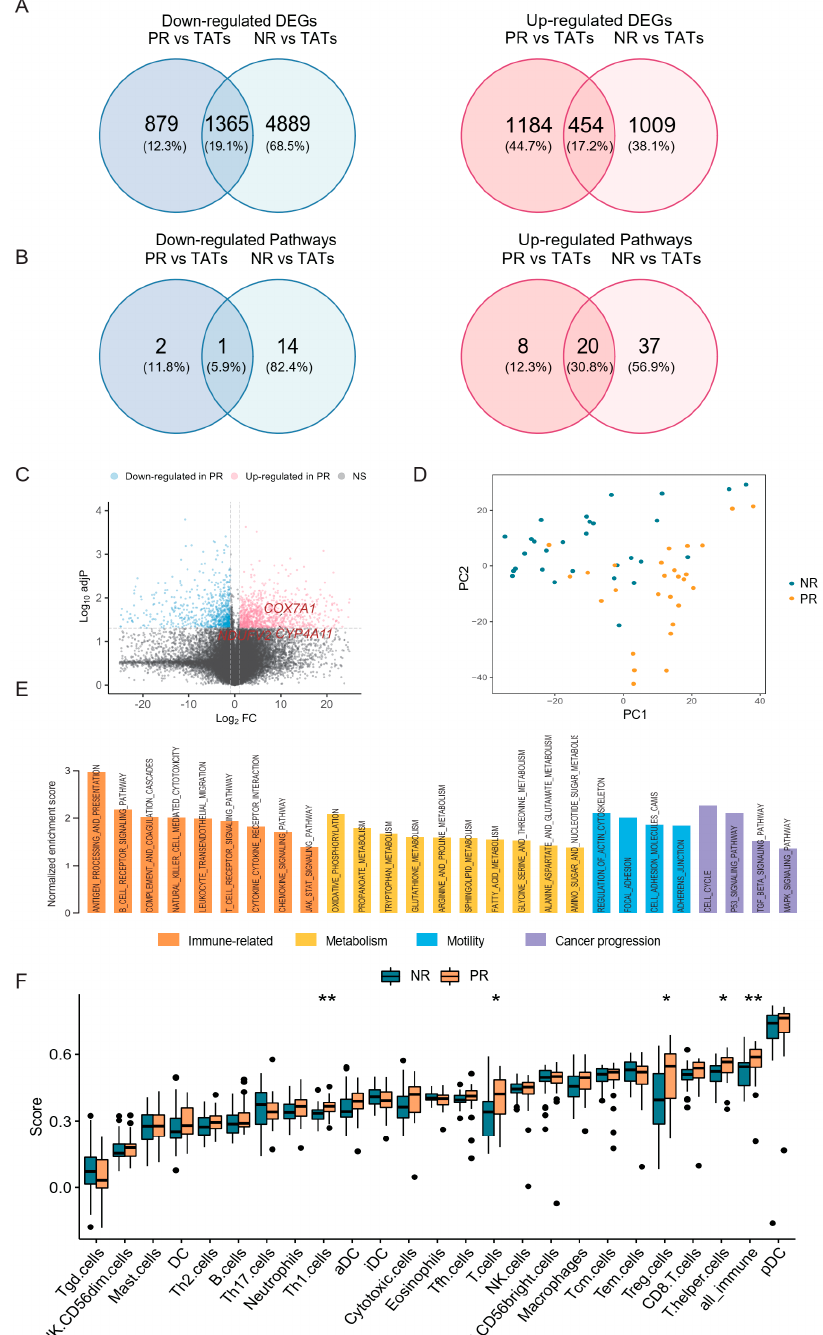
Figure 2. The difference of transcriptional profile between PR and NR. ( A ) Venn diagram showing the overlap of DEGs in PR and NR. DEGs, differentially expressed genes; TATs, tumor adjacent tissues. ( B ) Venn diagram showing the overlap of enriched pathways (based on DEGs) in PR and NR (see also Figure S7). ( C ) Volcano plot showing the upregulated (red) and downregulated genes (blue) in PR compared with NR. Vertical and horizontal dashed lines represent the cutoff for Log2FC (1 for upregulated and -1 for downregulated) and adjusted p -value (0.05). DEGs related to oxidative phosphorylation and fatty acid metabolism are indicated in red. ( D ) Principal component analysis showing the separation of NR and PR tumors. ( E ) Barplot showing the enrichment score of significantly enriched KEGG pathways in PR versus NR analyzed by GSEA. ( F ) Immune cell infiltration calculated by ssGSEA in NR and PR tumors. * p < 0.05, ** p <